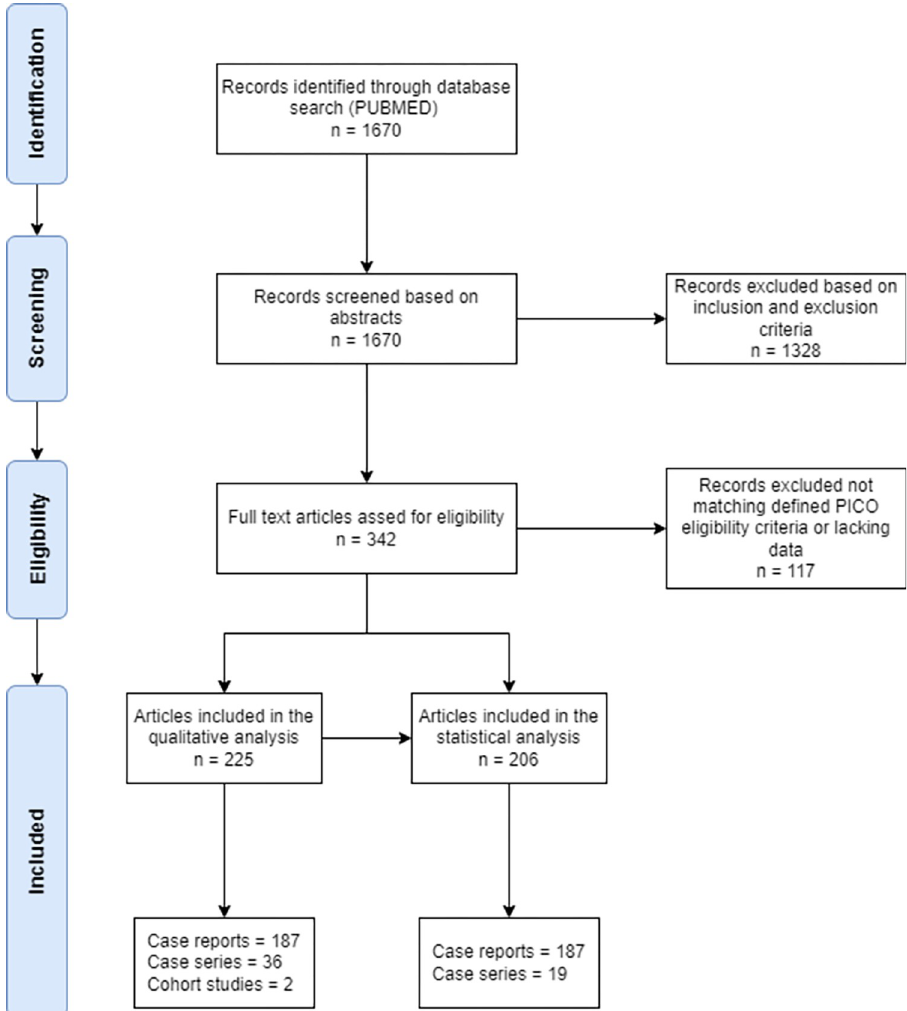
Fig 1. PRISMA flow diagram showing articles selection